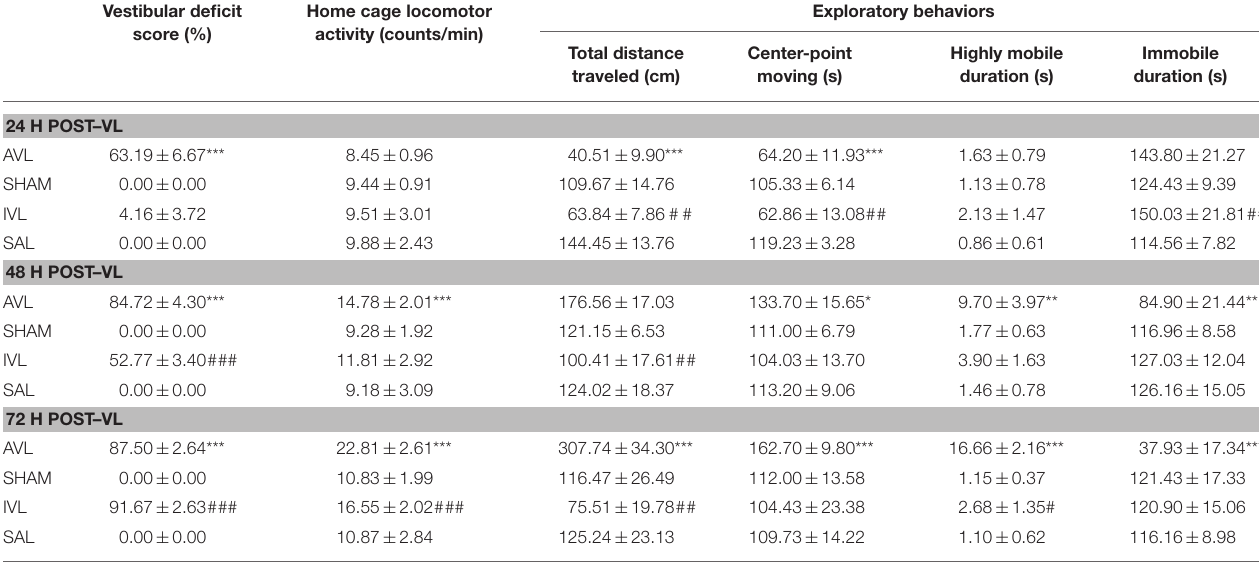
TABLE 1 | Effects of vestibular lesion (VL) on the vestibular deficit syndrome, home cage locomotor activity and exploratory behavior. Vestibular deficit Home cage locomotor score (%) activity (counts/min)